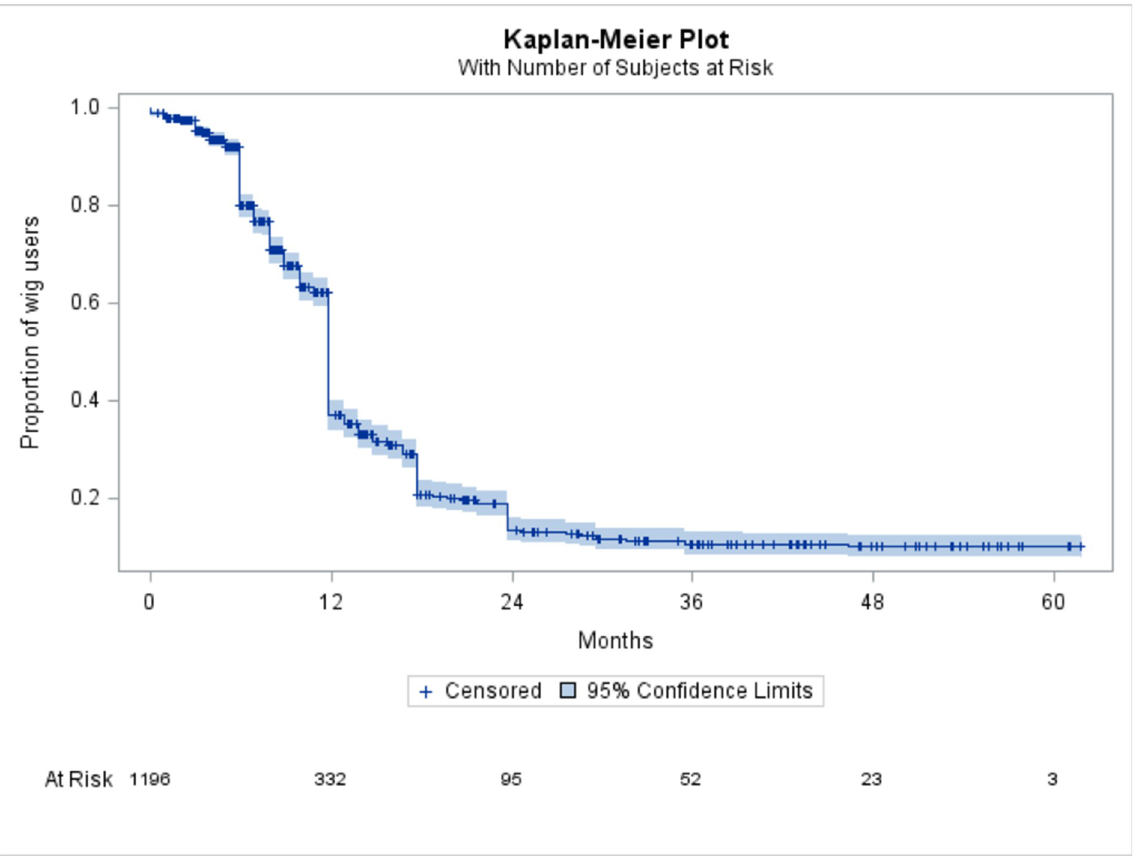
Fig 1. Period of wig use. The wig usage rates at 12, 24 and 36 months were estimated to be 37.3%, 13.5 and 10.3% based on the Kaplan-Meier plot.